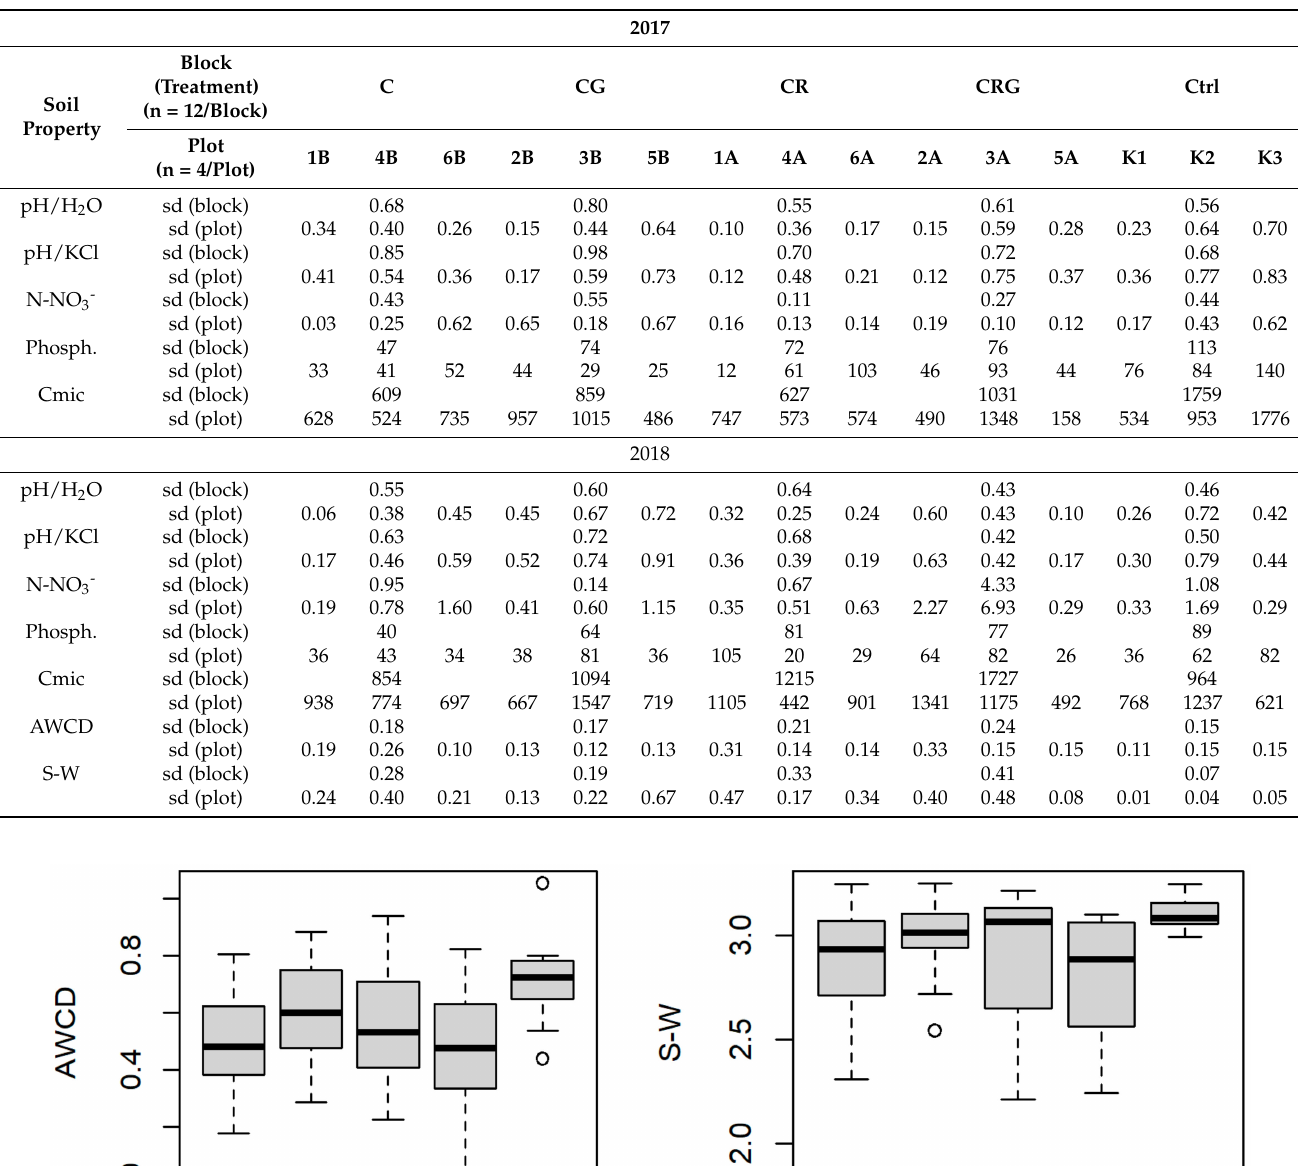
Table 3. Spatial heterogeneity (standard deviation) of the soil properties with significant differences detected by ANOVA within blocks (C, CG, CR, CRG and Ctrl) and study plots (1A–6B and controls K1–K3) in 2017 and in 2018.